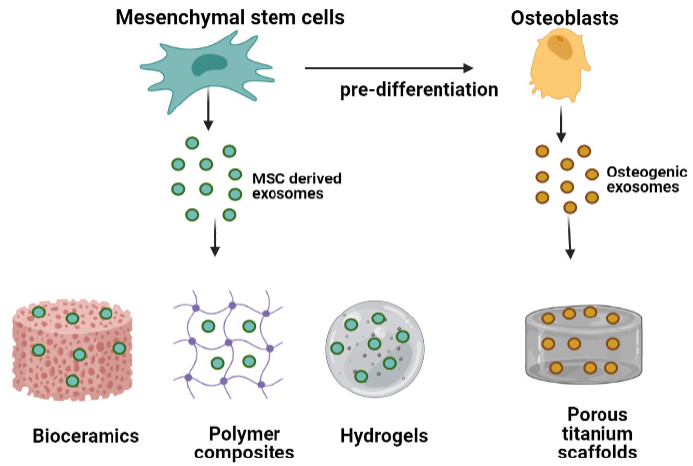
Figure 4. Schematic representation of exosome conjugation strategies over bone specific biomaterials. Exosomes derived from both mesenchymal stem cells as well as osteogenically pre-differentiated MSCs have been immobilized over bioceramics, polymer composites, hydrogels (as carriers), and titanium scaffolds for